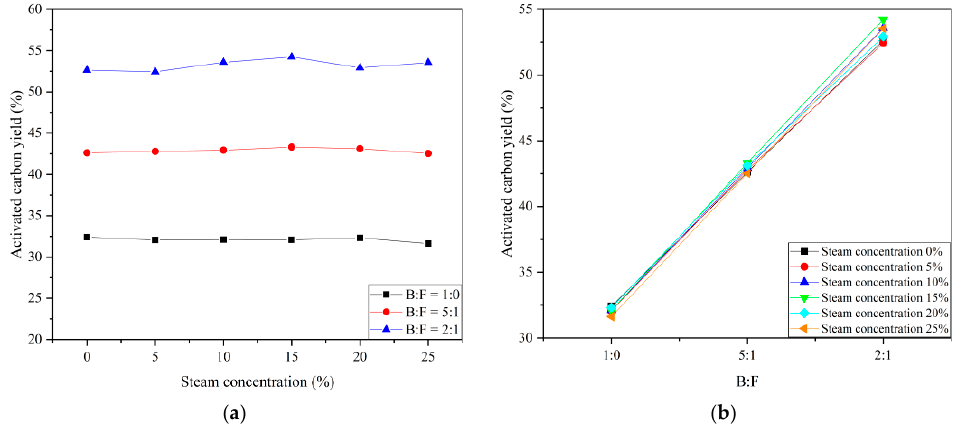
Figure 4. Variation trend of the yield of activated carbon with respect to the steam concentration and raw material mixing ratio: ( a ) different steam concentrations and ( b ) different mixing ratios of raw materials.